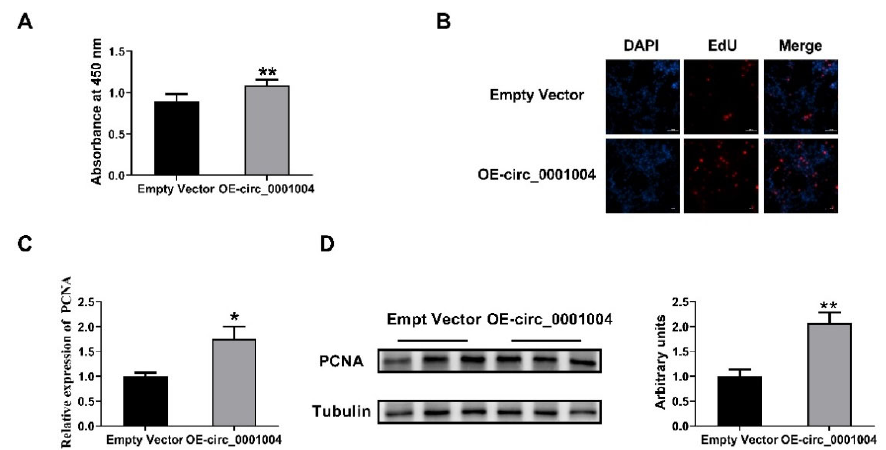
Figure 4. Rno_circ_0001004 promoted the viability of GH 3 cells ( A ) The GH 3 proliferation was evaluated with CCK-8 kits. ( B ) Cell proliferation tested by an EdU assay. ( C ) PCNA mRNA expression quantified by qRT-PCR. ( D ) Western blot assay for PCNA protein expression. (* p < 0.05; ** p < 0.01.)